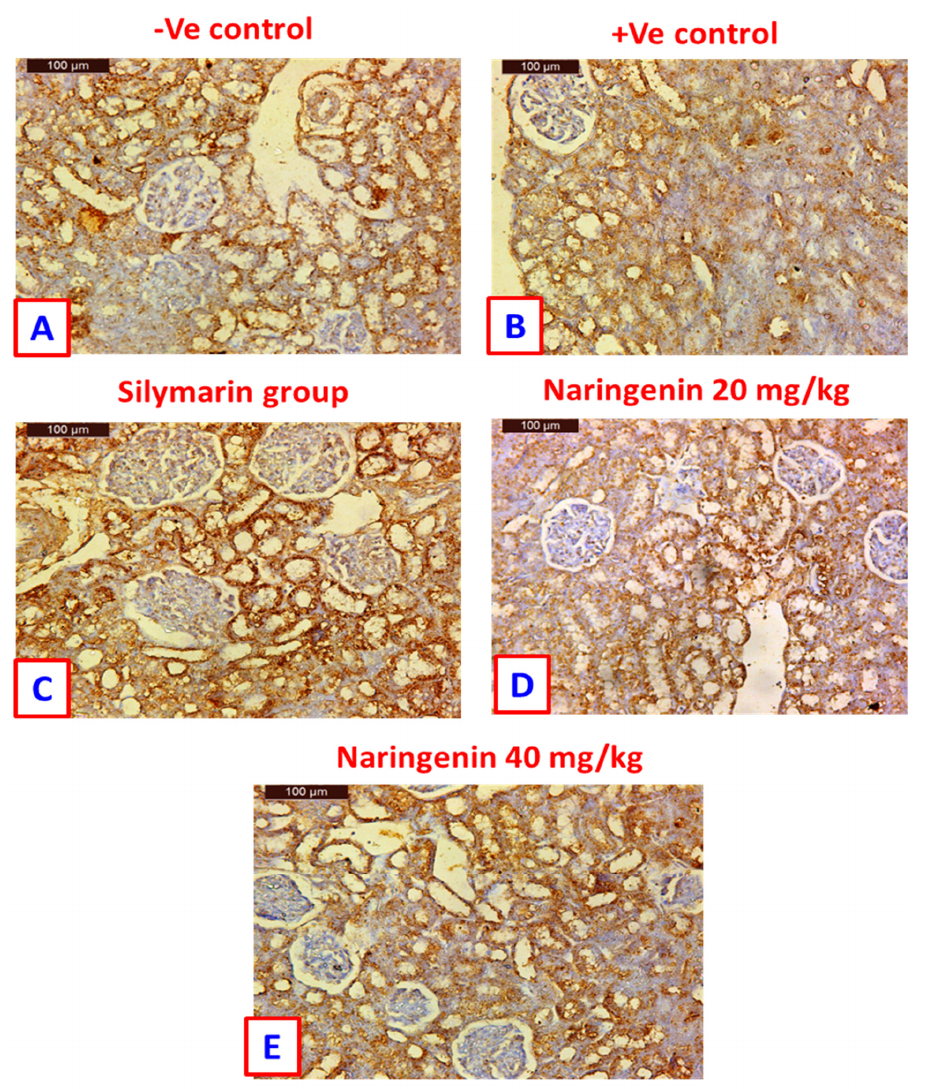
Figure 4. Immuno-histochemical detection of Bcl-2 in kidney tissues: ( A ) control rat showing positive staining in the renal tubules, contrasted with non-staining glomeruli; ( B ) positive control rat showing negative staining in the damaged tubules, while the healthy one shows positive staining; ( C ) rat treated with silymarin drug showing high immuno-histochemical expression in the renal tubules as compared to the positive control; ( D ) kidney sample of rat treated with 20 mg/kg of naringenin showing positive immuno-histochemical expression in the renal tubules and negative expression in the glomeruli; ( E ) rat treated with naringenin (40 mg/kg) showing greater immuno-histochemical expression of Bcl-2 than in the rat treated with naringenin (20 mg/kg) (immuno-histochemical expression of Bcl-2; scale bar: μ m).